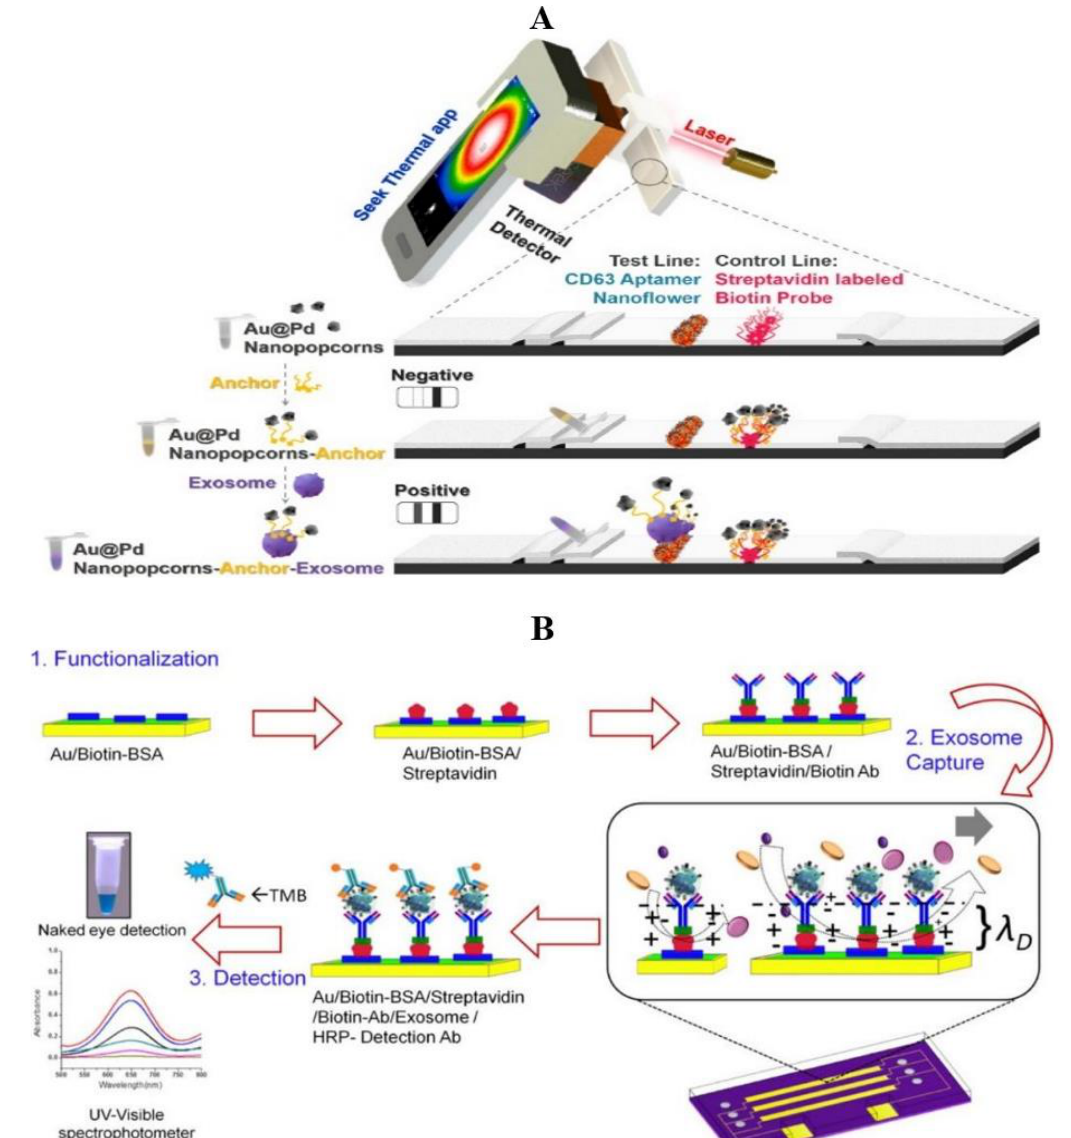
Figure 11. Other methods for the detection of exosomes in breast cancer. ( A ) Schematic illustration of the strategy of integrating an ANAN-LFS with a smartphone-based thermal reader [168]; ( B ) schematic representation of device functionalization, exosome capture, and colorimetric detection of the captured exosomes [169].